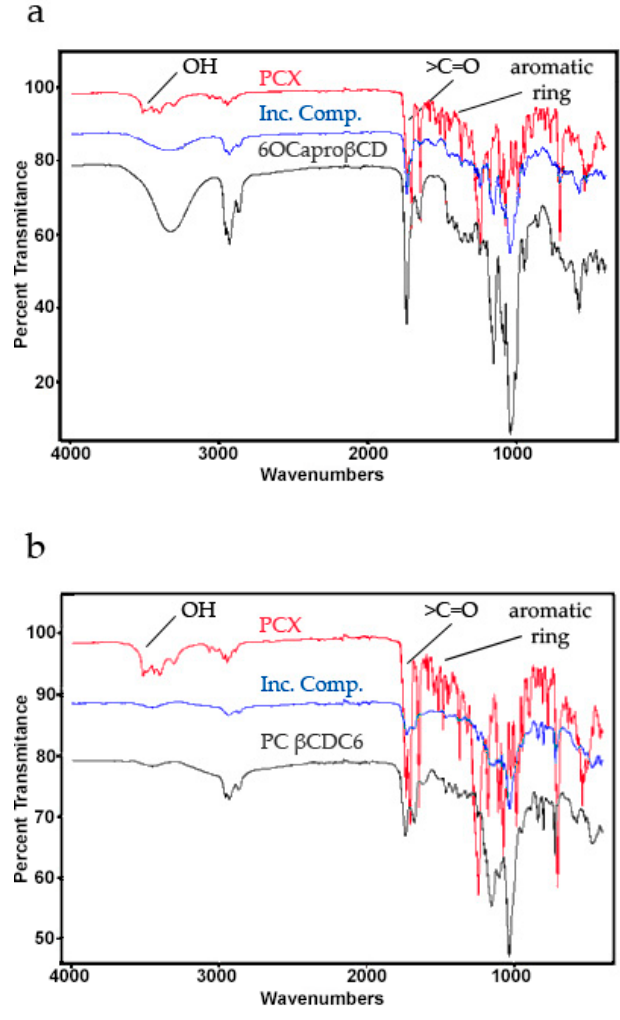
Figure 3. Fourier Transform Infrared Spectroscopy (FT-IR) spectra of PCX, 6OCapro β CD, PCX: 6OCapro β CD inclusion complex ( a ) and PC β CDC6, PCX:PC β CDC6 inclusion complex ( b ).